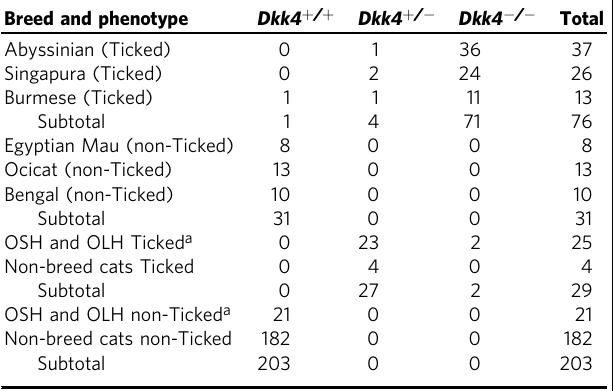
Table 1 Dkk4 genotypes in Ticked and non-Ticked cats. Breed and